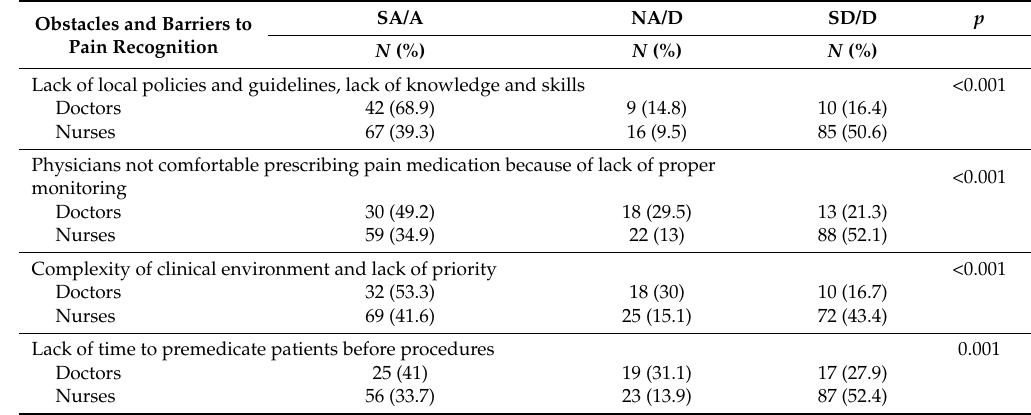
Table 4. Perceived obstacles/barriers to pain recognition among orthopedic doctors and nurses ( N =